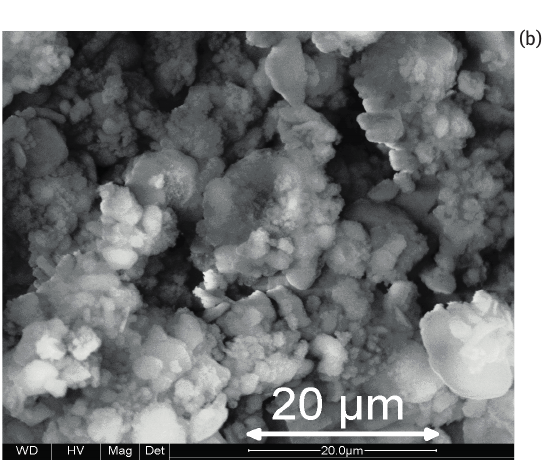
= 2.3 μm by DLS). m